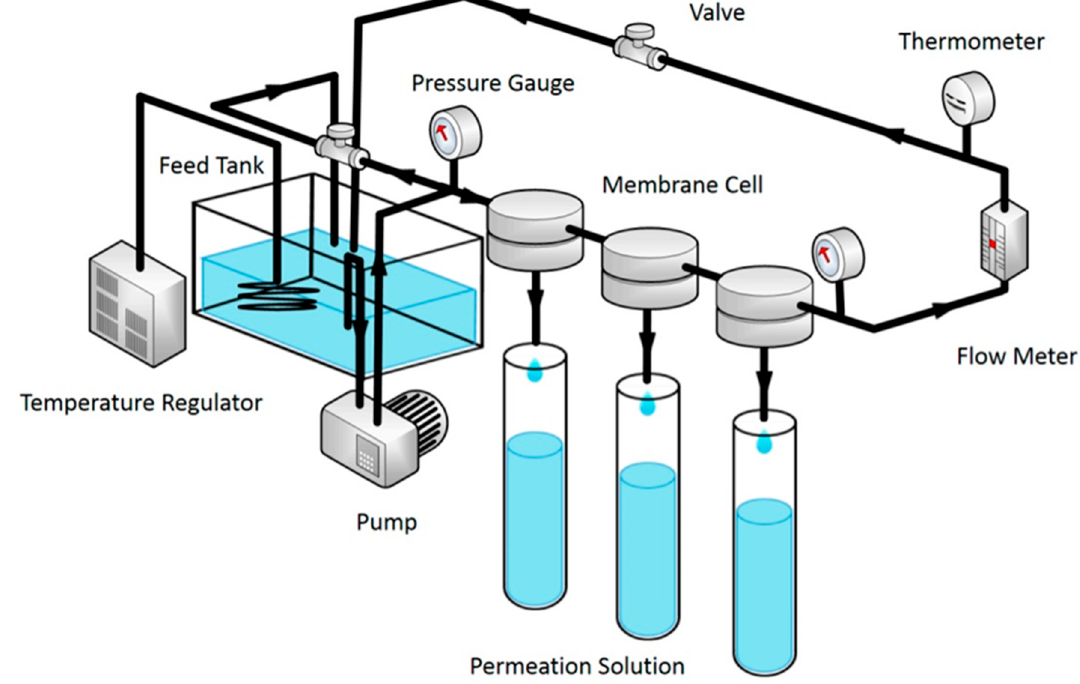
Figure 9. A schematic representation of the reverse osmosis (RO) system used to test the thin film nanocomposite (TFN) membrane doped with MIL-101(Cr) [40]. nanocomposite (TFN) membrane doped with MIL-101(Cr)